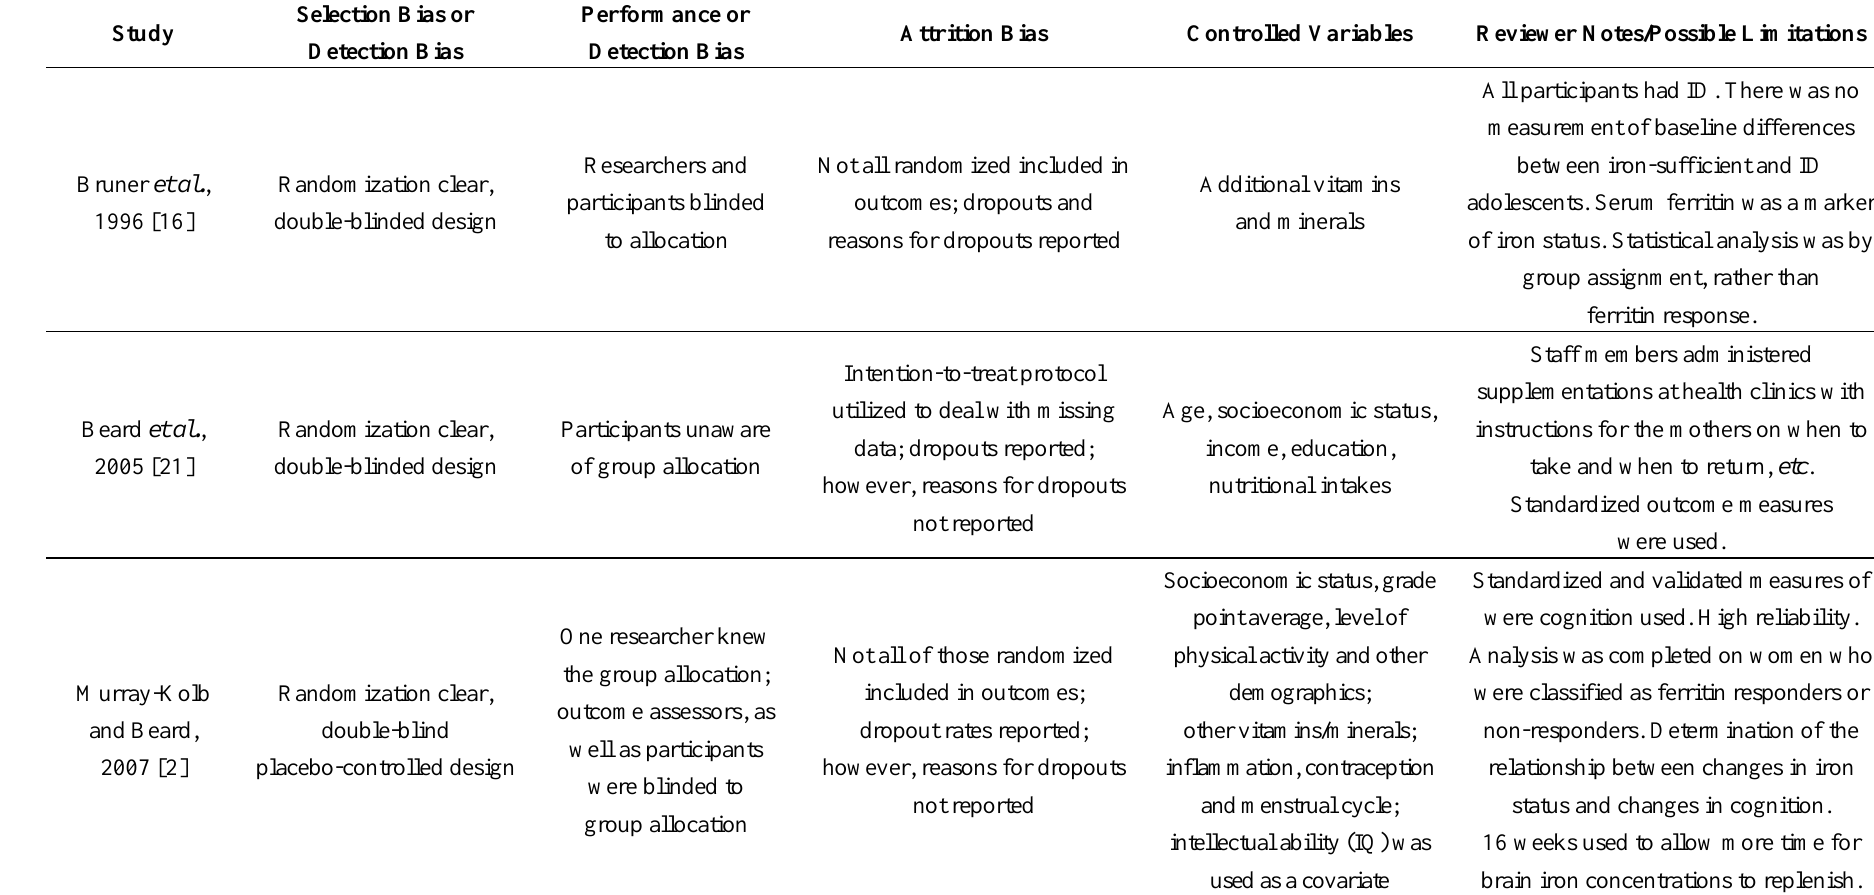
Table 2. Validity Characteristics of included